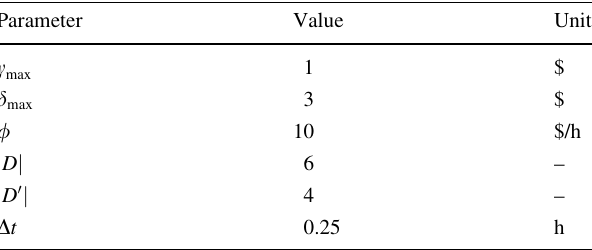
Table 2 Parameters of cordon pricing problem for Sioux Falls